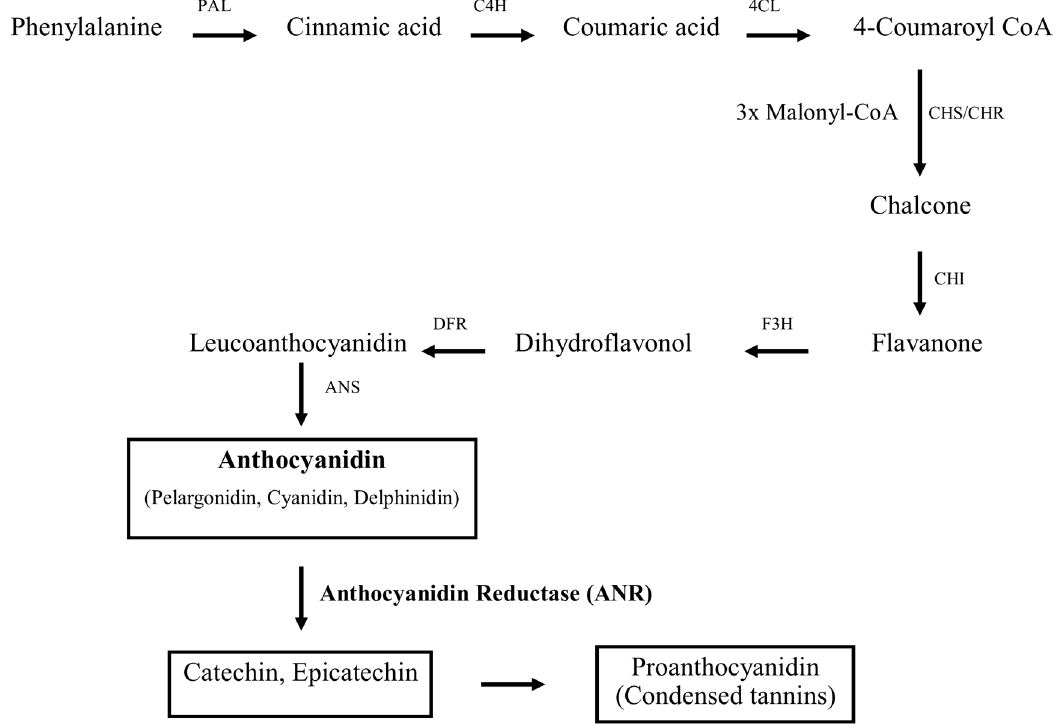
Figure 1. Scheme of the proanthocyanidin synthesis pathway.